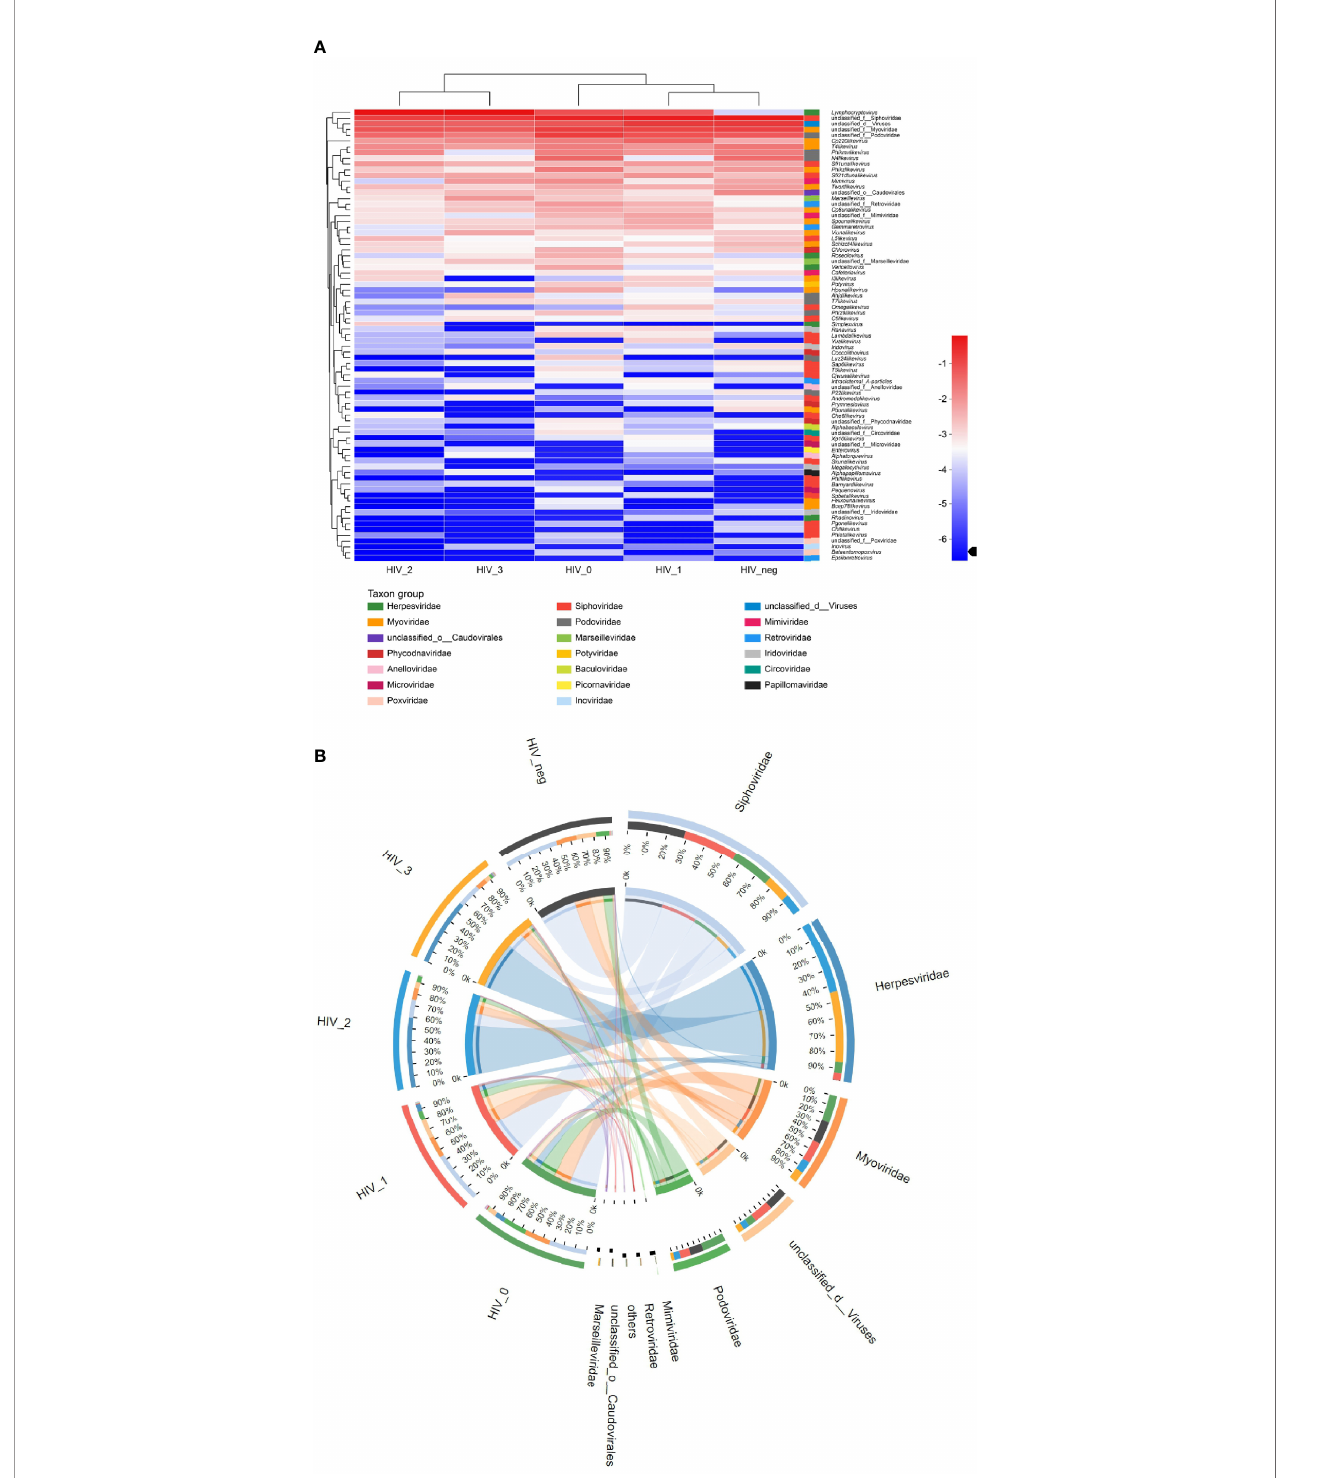
FIGURE 2 | Community composition analysis diagram. (A) Heatmap visualizing the abundance of all viruses in saliva samples at the genus level. The left and upper sides are the species cluster tree and the sample cluster tree, respectively; the right and lower sides are different taxon groups of the family. Color intensity represents species abundance. (B) Circos diagram visualizing the abundance of viruses in saliva samples at the family